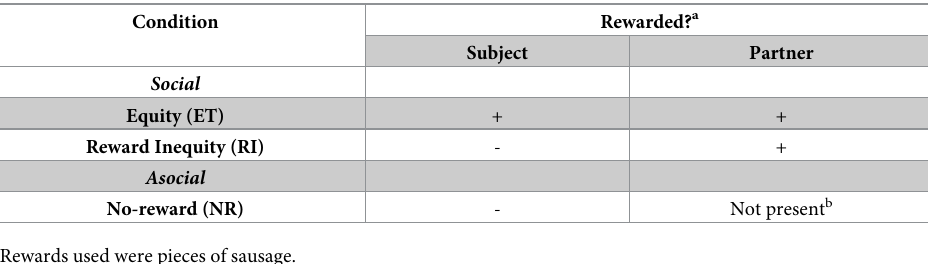
Table 1. Conditions used in the paw